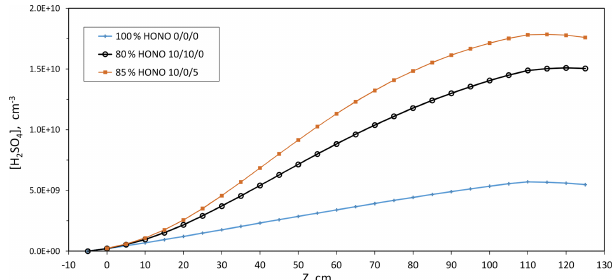
Figure 3. Simulated centerline H 2 SO 4 vs. axial distance for three different HONO decomposition scenarios where the last three num- bers are the %NO, NO 2 , and HNO 3 , respectively. Parameters: HONO photolysis rate of 4 . 0 × 10 − 4 s − 1 , 17ppmv NO x ( + HONO) in Q 4 , and no reaction between HO 2 and SO 2 . These simulations were run for Q 4 = 4 . 2sccm. The 100% level of HONO is a con- centration of 5 . 79 × 10 11 cm − 3 or ∼